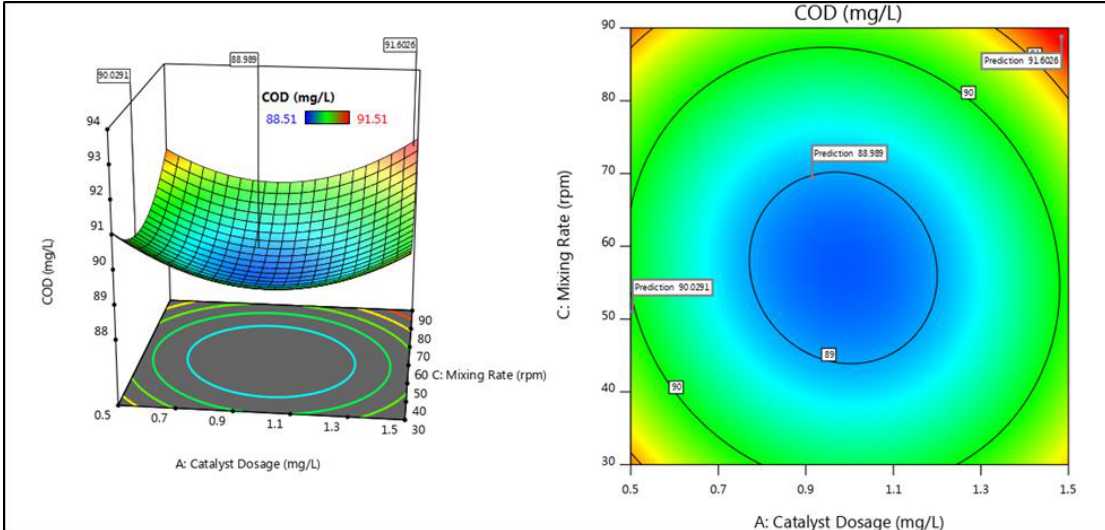
Figure 5. 2D and 3D plots representing the cross factor interactive e ff ects of the interactions between catalyst dosage and mixing rate (AC) on COD removal by TiO 2